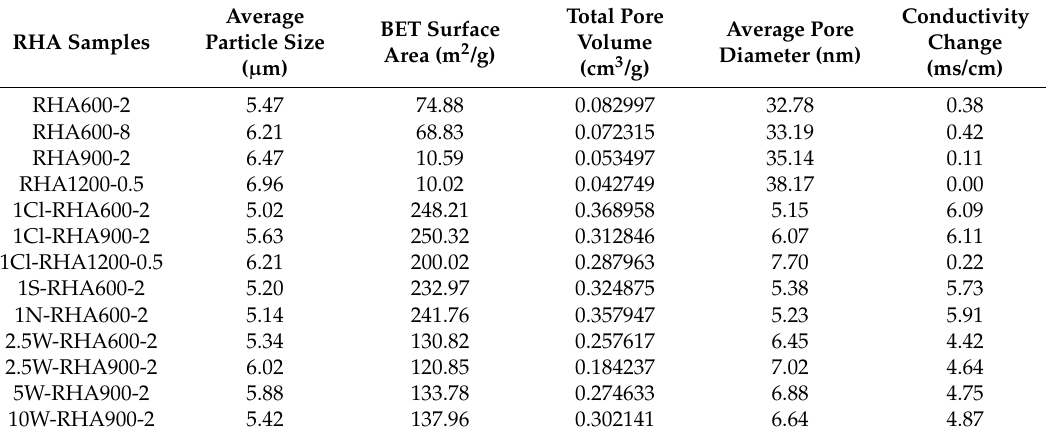
Table 2. Particle size, BET surface area, and conductivity of